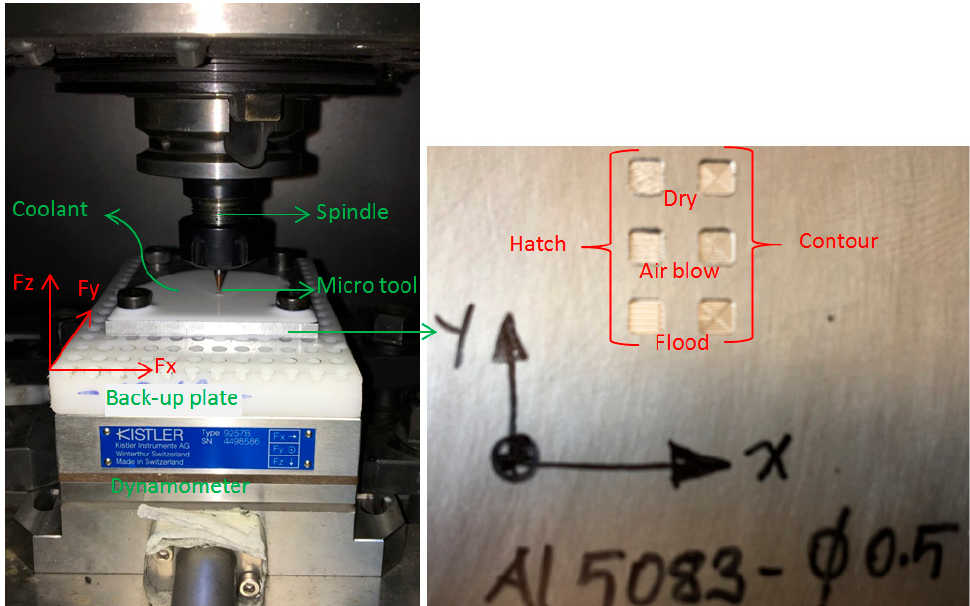
Figure 1. Experimental set-up and machined workpiece. Table 1. Chemical compositions and mechanical properties of the AA 5083 H116 aluminum alloy.